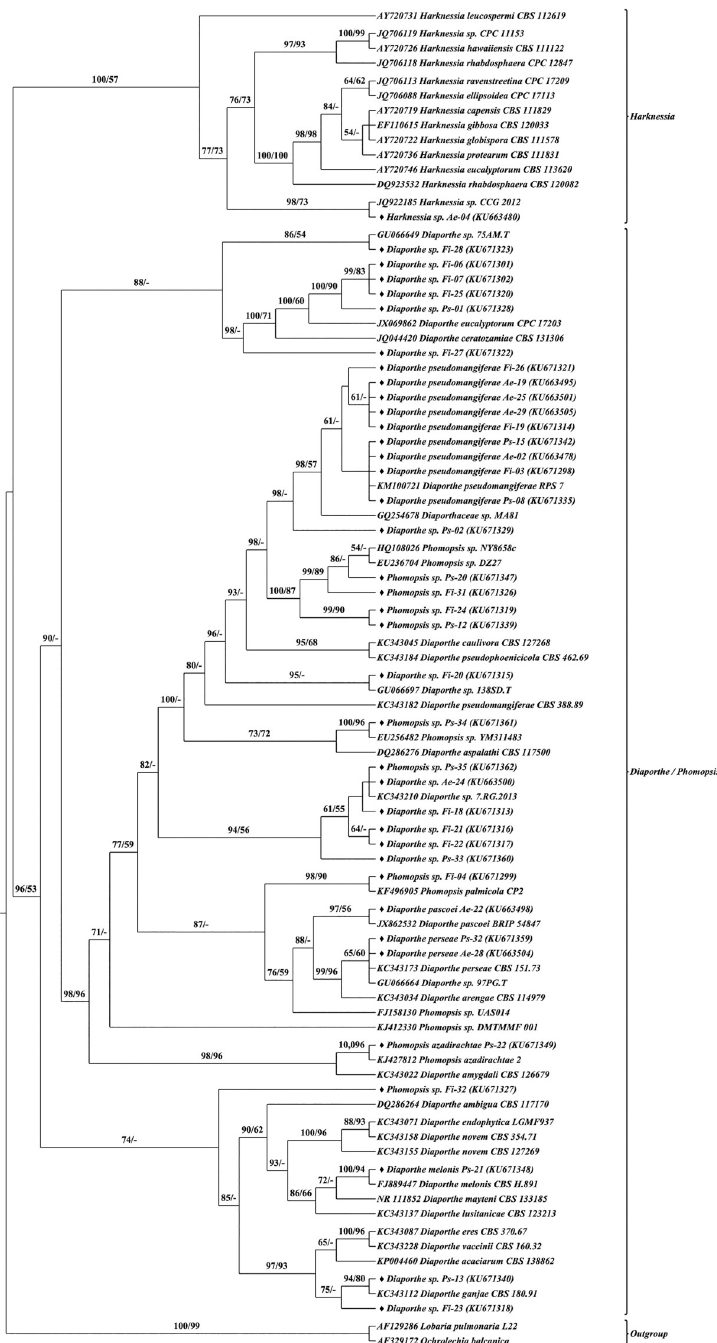
Fig 8. Internal transcribed spacer 2 sequence–secondary structure based phylogenetic tree of Diaporthales query and reference sequences. The query sequences are represented by the symbol “ ♦ ”. Bootstrap (BP) values � 50 were represented in the tree. Maximum Likelihood tree was presented with branch support values as BP of ML tree / BP of NJ tree.